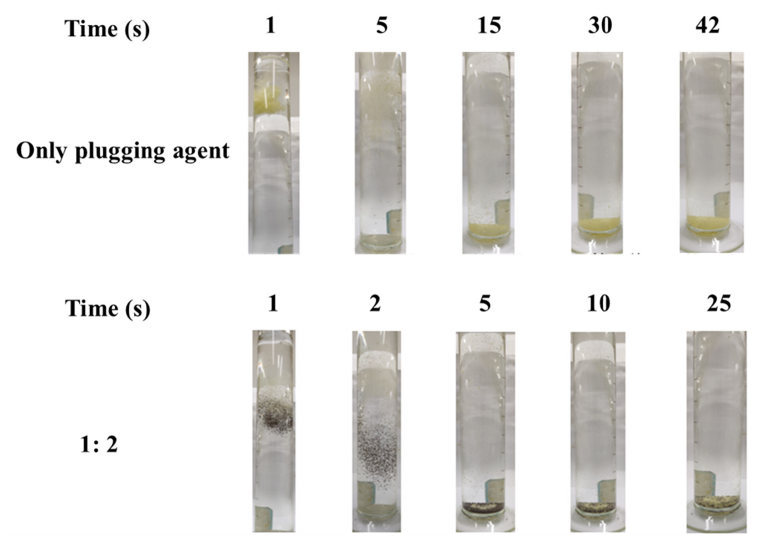
Figure 11. Settlement of the plugging agent and proppant (density = 1.15 g/cm 3 ) in water.